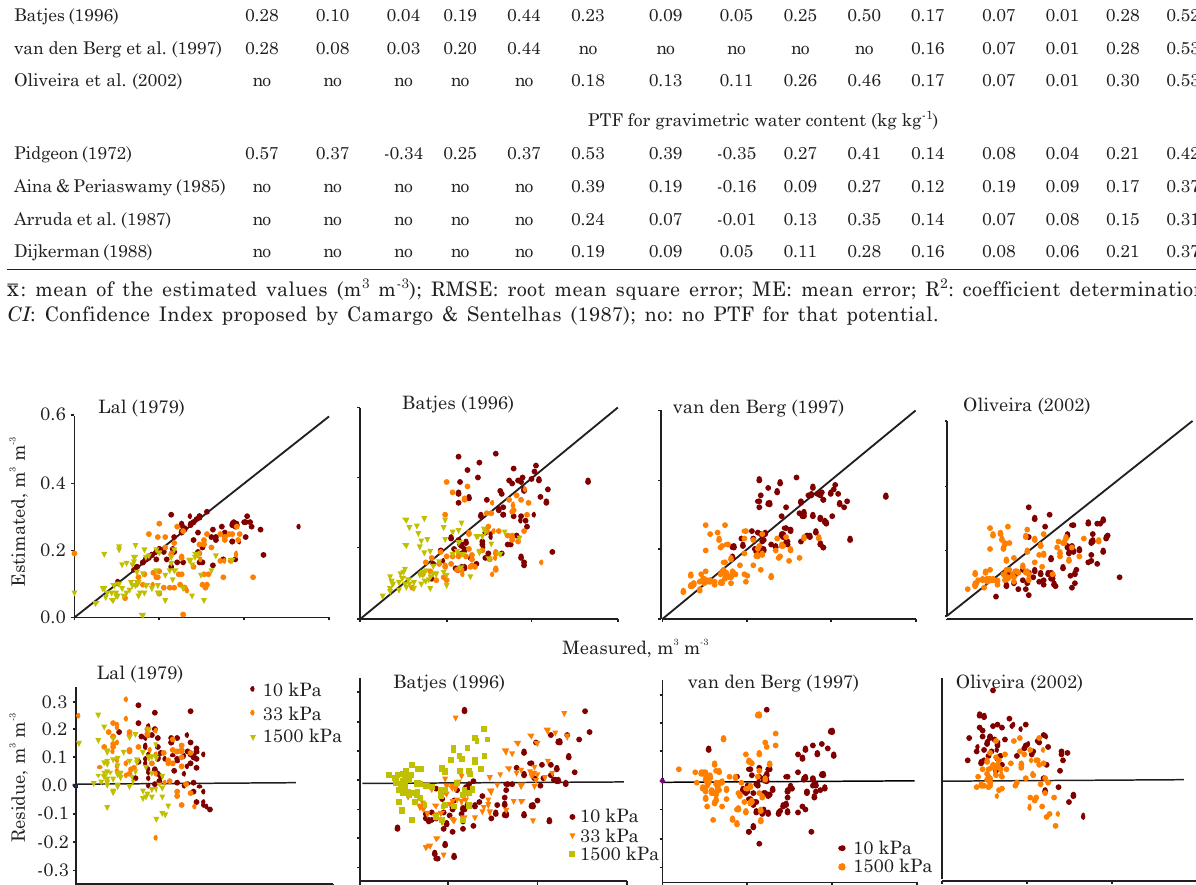
Figure 6. Estimated vs measured volumetric water content, and estimation residues of the point PTFs tested for all depths (n =